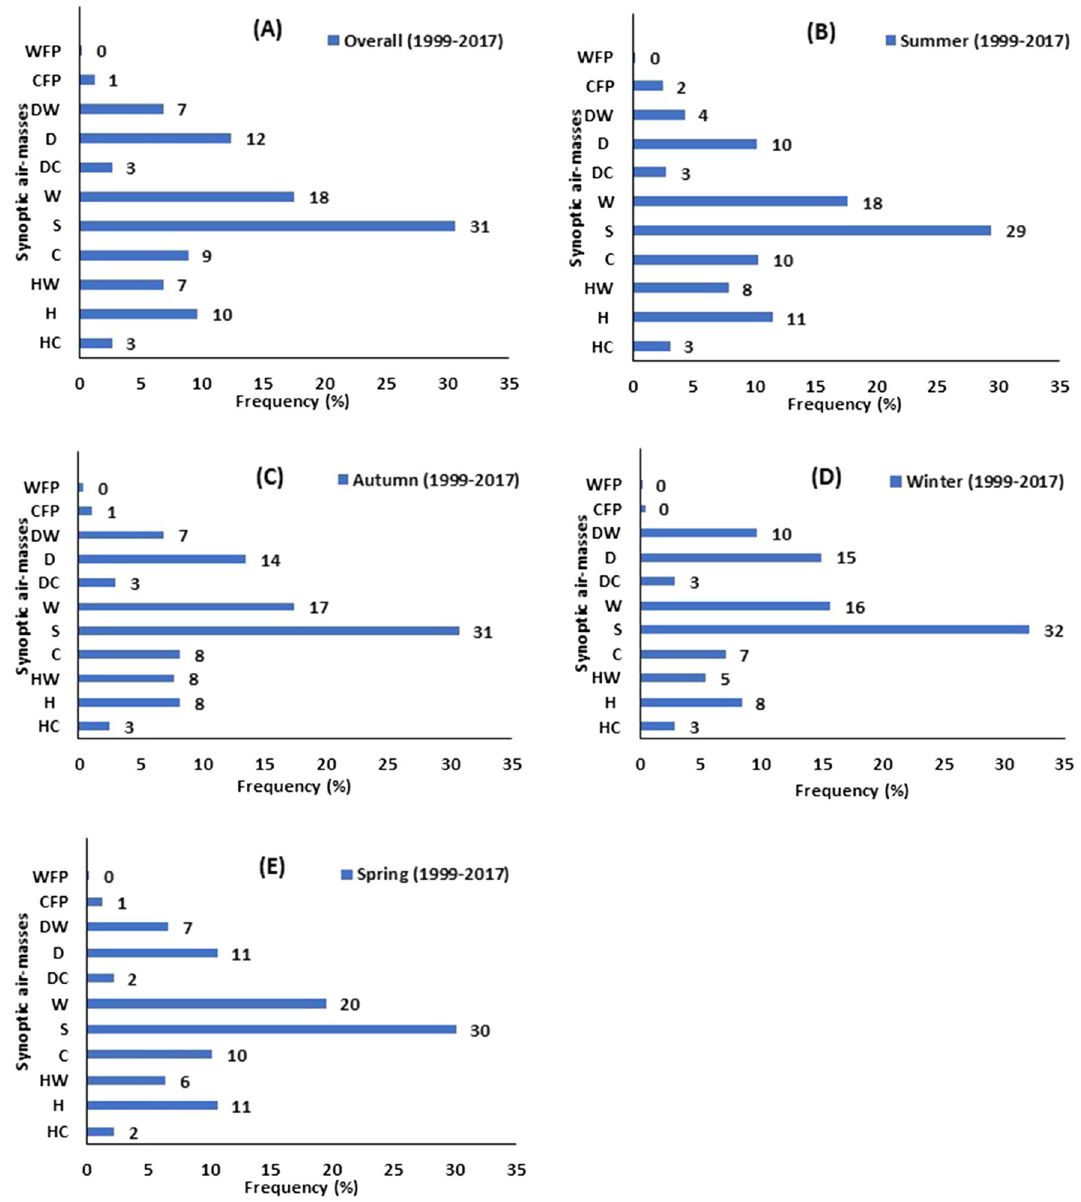
Figure 1. Synoptic air-masses Frequency from 1999 to 2017, ( A) Overall, ( B) Summer (DJF), ( C) Autumn (MAM), ( D) Winter (JJA), ( E) Spring